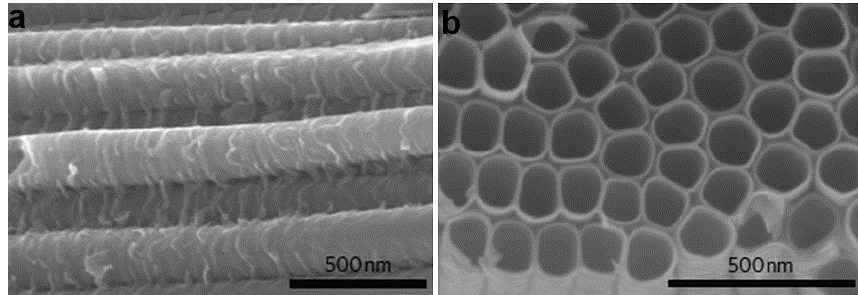
Figure 2. Engineering the surface/interface structures in TiO 2 materials via one step approach. ( a ) Cross section and ( b ) front view scanning electron microscopy (SEM) images of amorphous TiO 2 nanotube arrays fabricated by anodic oxidation. Reproduced with permission from [47], Copyright